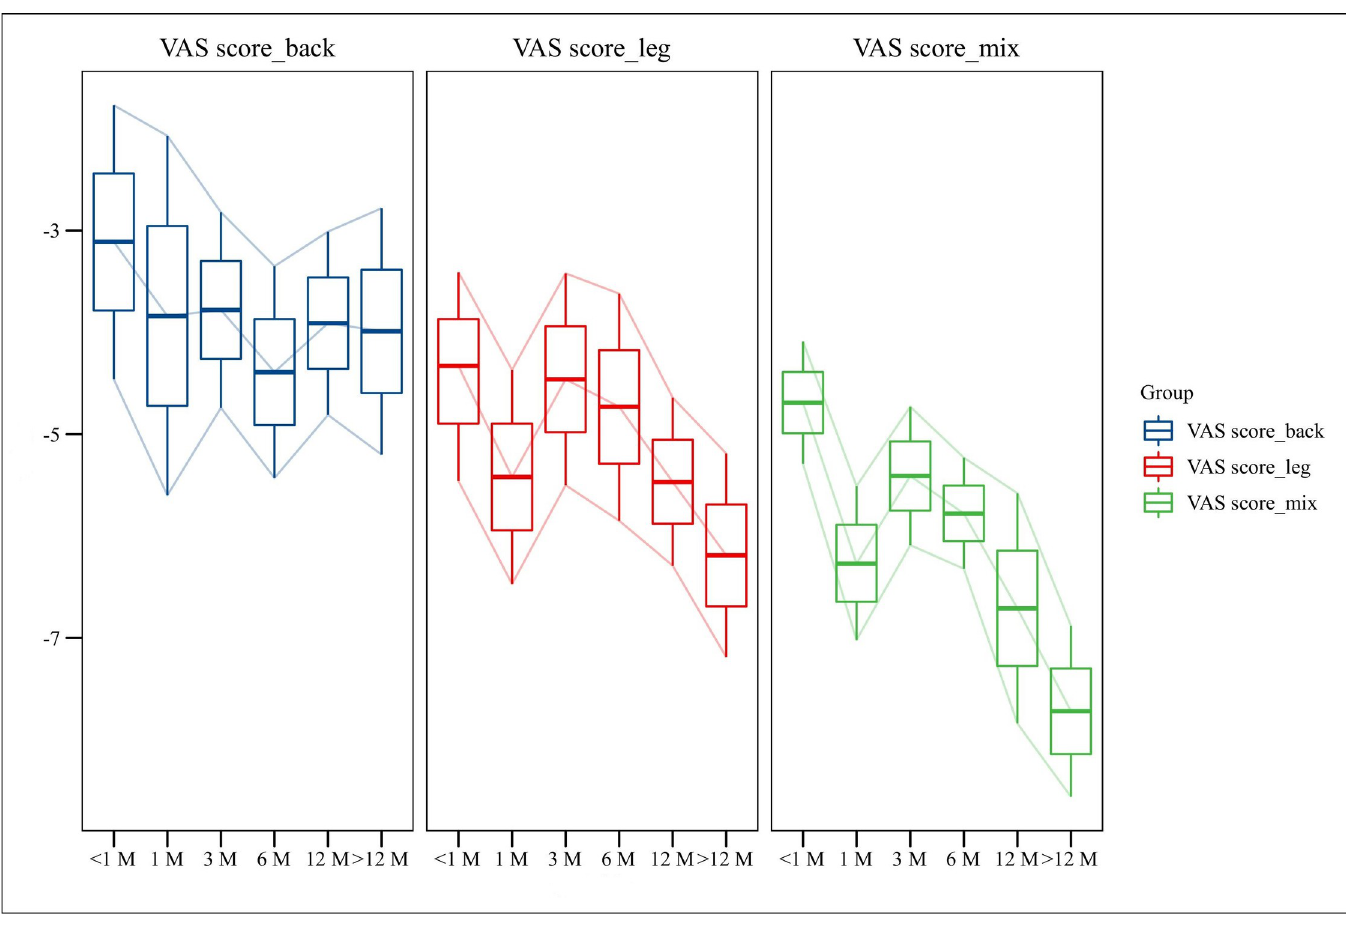
Fig 2. Development trend of postoperative VAS